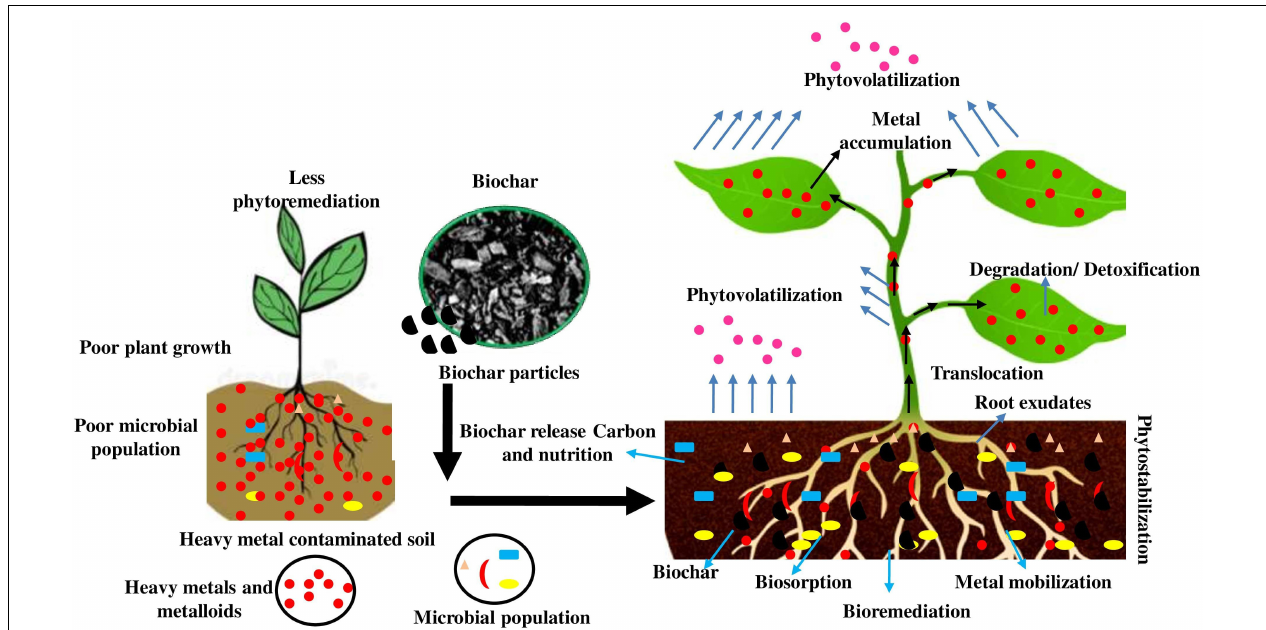
FIGURE 1 | Biochar fabrication from various agricultural